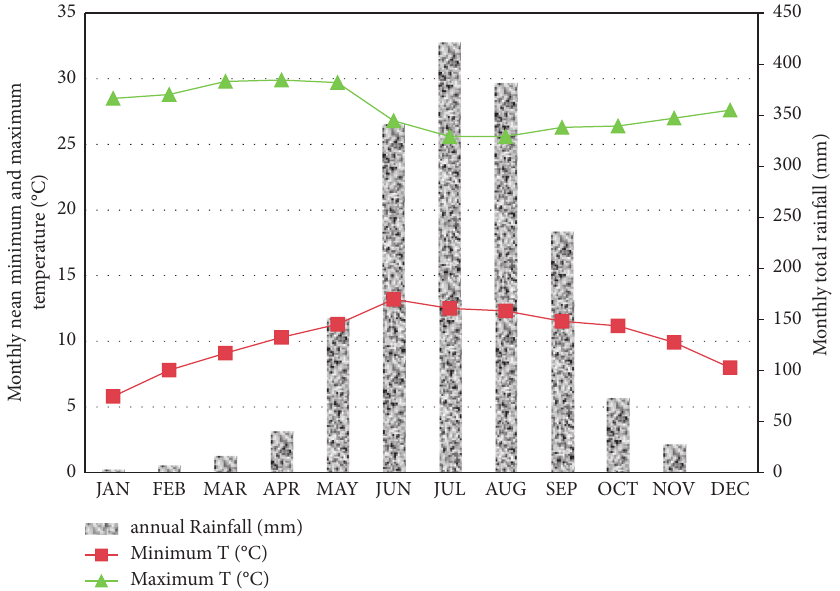
Figure 1: Monthly average rainfall and minimum and maximum temperatures of the study area in